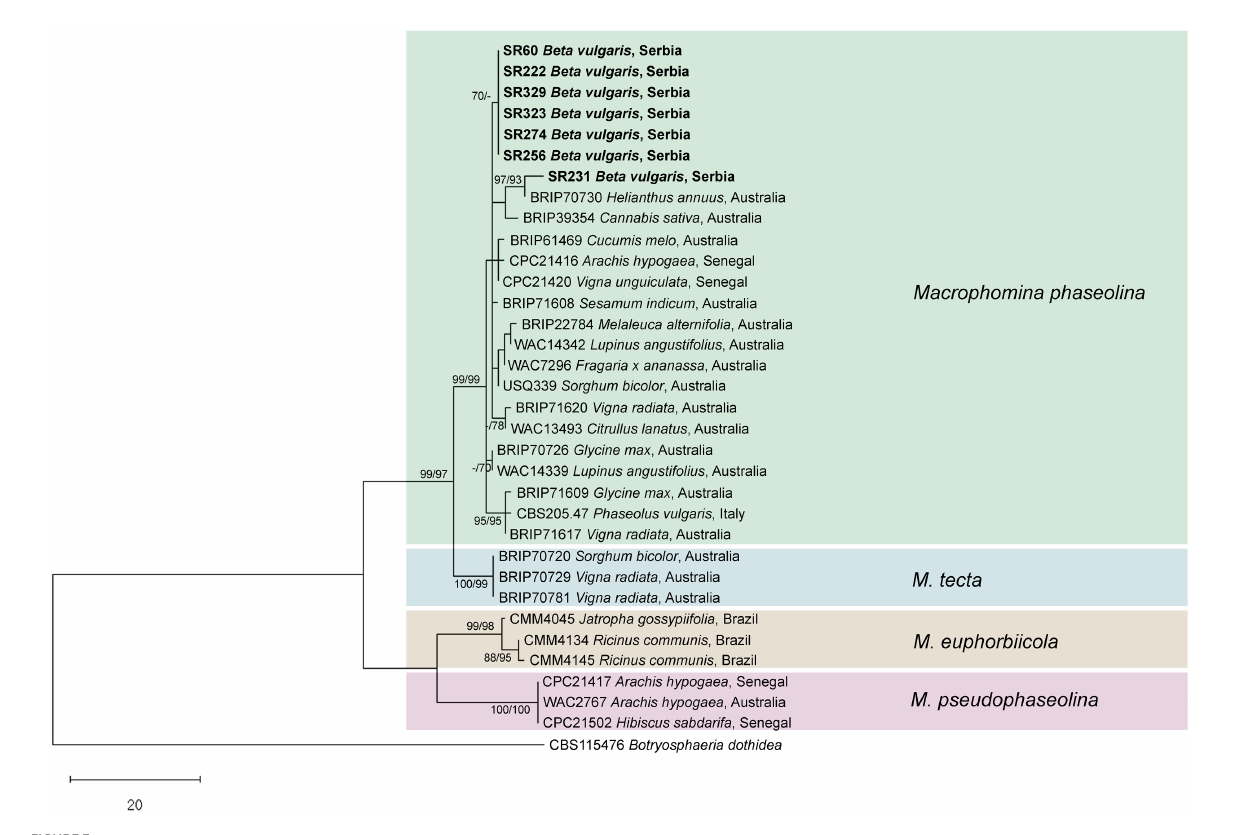
FIGURE 3 Phylogenetic tree resulting from the analysis of concatenated ITS, TEF1- α , ACT, CAL, and TUB sequences of Macrophomina spp. Numbers on the branches represent maximum parsimony and maximum likelihood bootstrap values (MP/ML) from 1,000 replicates. Values less than 70% are marked with “-.” The tree was rooted to Botryosphaeria dothidea . The scale bar represents 20 nucleotide substitutions. Isolates obtained in this work are shown in